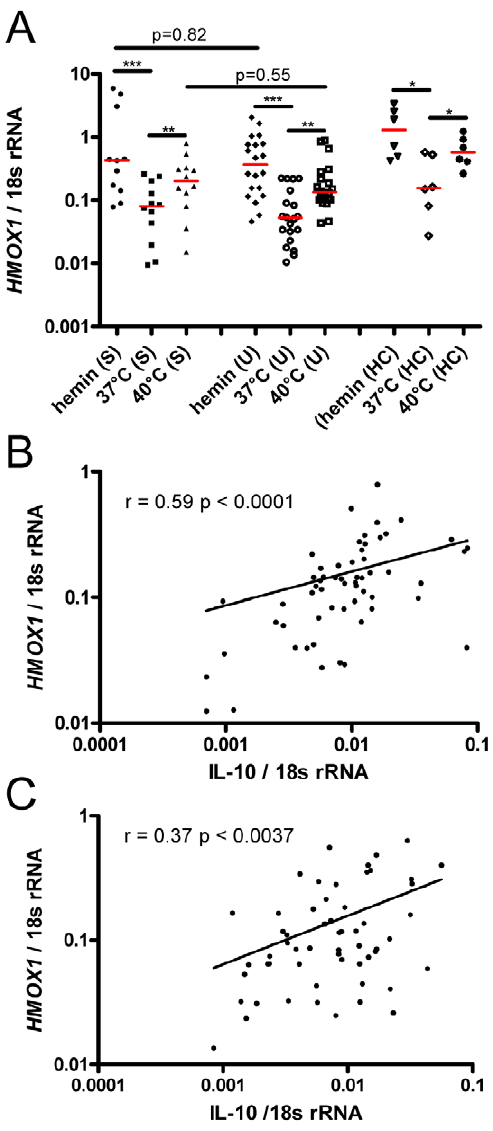
Figure 5. Other factors associated with HMOX1 mRNA expres- sion. A) HMOX1 mRNA was measured in whole blood from convalescent SM (n=12) and UM (n=14) cases and healthy controls (HC, n=6). For 3 hours, blood was kept in a water bath at 37 u C, 40 u C or stimulated at room temperature with hemin. Measurements within each group (SM, UM, HC) were compared using the Friedman test, (a non-parametric ANOVA for repeated measures) with Dunn’s post-test adjustment for multiple comparisons. Differences between SM and UM for hemin or heat induction were assessed using the Mann Whitney test. The red lines indicate the medians. * p # 0.05, ** p # 0.005, *** p # 0.0005. mRNA levels for HMOX1 and IL-10 measured on day 0 were correlated for B) 58 SM [r: 0.59, p , 0.0001] and C) 59 UM cases [r: 0.37, p=0.0037].